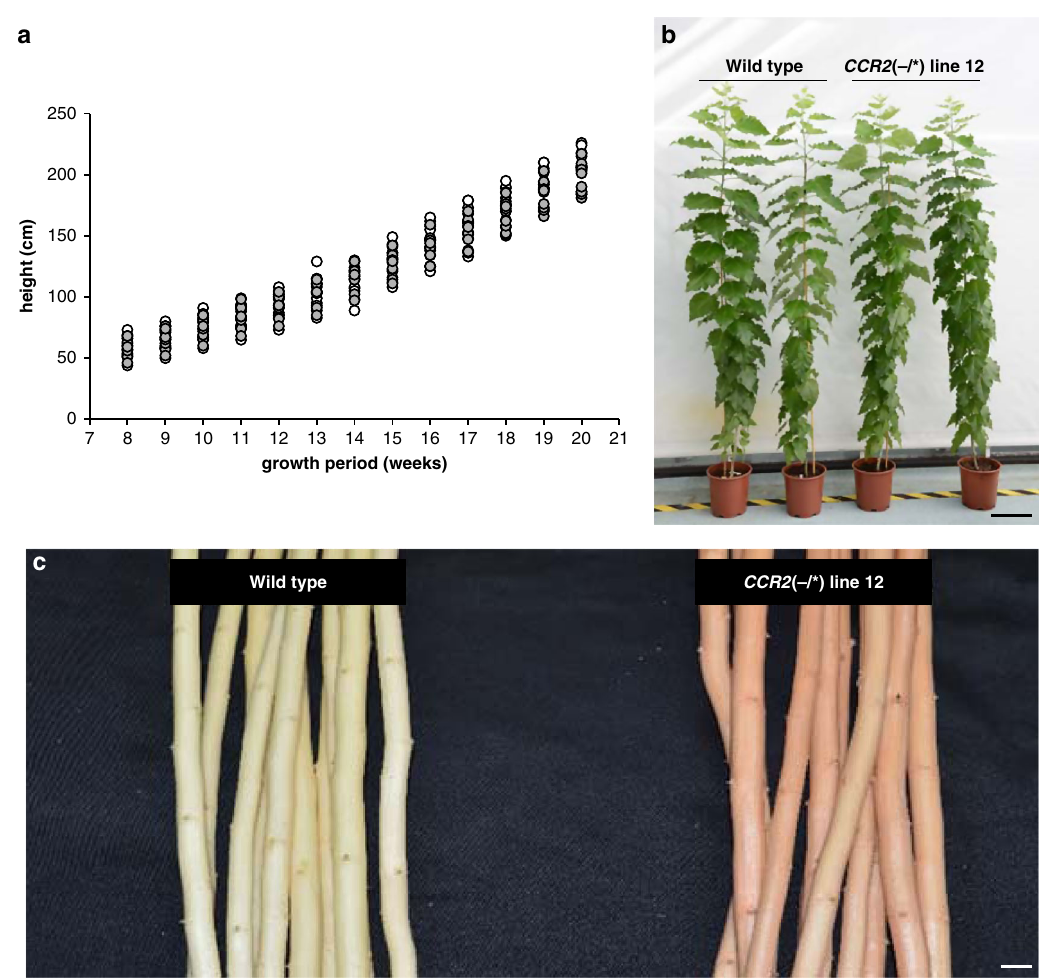
Fig. 2 Phenotype of CCR2 ( − /*) line 12 poplar. Plants were grown for 20 weeks in the greenhouse. a Growth curve of wild type and CCR2 ( − /*) line 12. No signi fi cant differences in height were found between the wild type (individual values shown in white dots) and CCR2 ( − /*) line 12 (individual values shown in gray dots) at the 0.01 signi fi cance level (two-tailed Student ’ s t -test). For mean values and exact P values, see Supplementary Table 1. b Phenotype of representative wild type and CCR2 ( − /*) line 12 after growing for 20 weeks in the greenhouse. Scale bar = 20 cm. c Phenotype of debarked wild-type and CCR2 ( − /*) line 12 stems grown in the greenhouse for 20 weeks. CCR2 ( − /*) line 12 stems display the red xylem phenotype. Scale bar = 10 mm. Wild type, n = 10 biologically independent samples; CCR2 ( − /*) line 12, n = 11 biologically independent samples. The source data underlying ( a ) are provided as a Source data fi